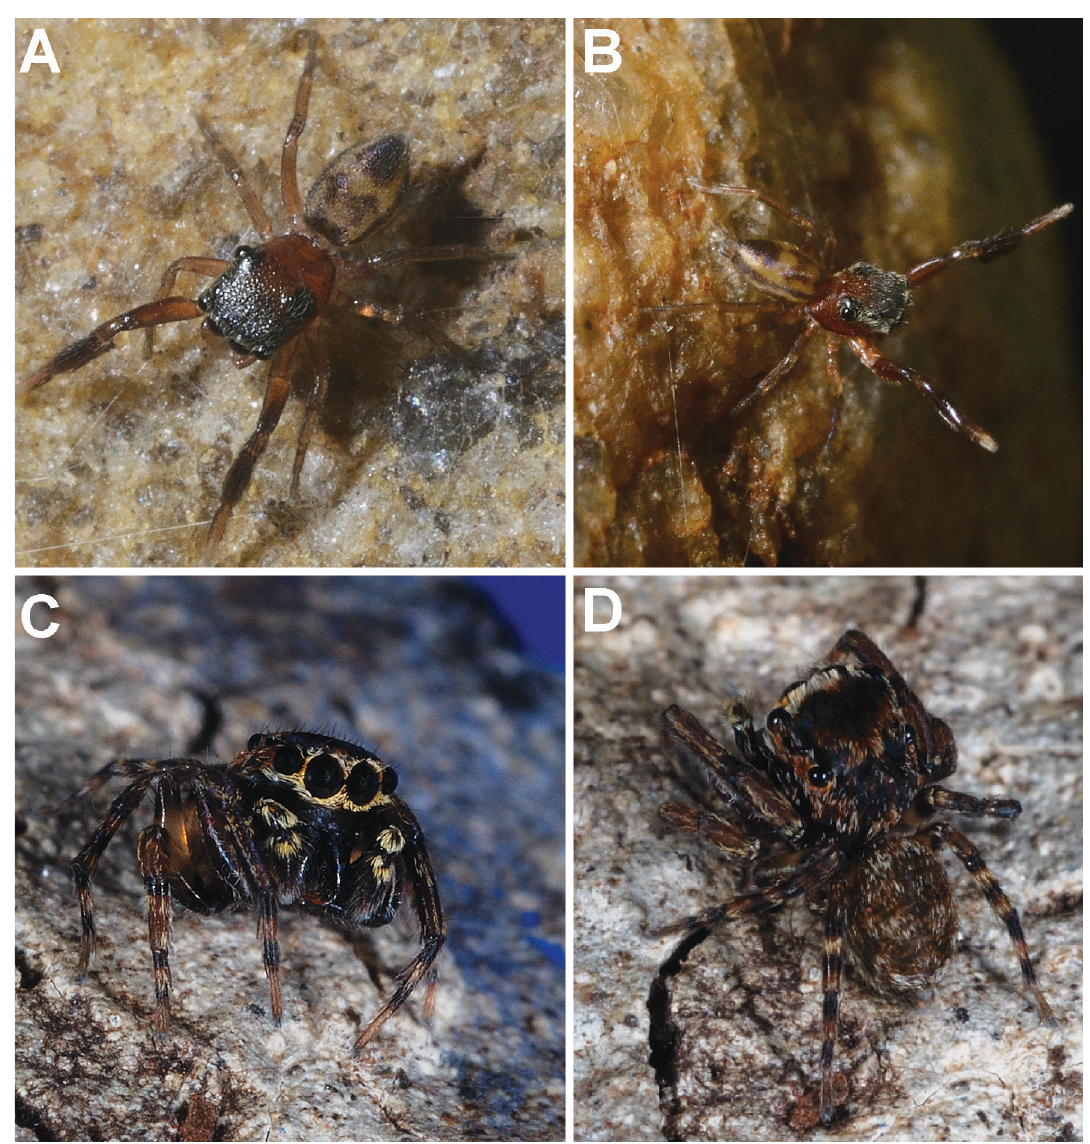
Fig. 2. Live specimens of Bristowia reimoser, 1934 and Habrocestum simon, 1876. A–B . B. gandhii sp. nov., ♀ from IFS Arboretum, Dambulla (IFS_SAL 543). C–D . H. kodigalaensis sp. nov., ♂ from Ritigala SNR, Kodigala, Sri Lanka (IFS_SAL